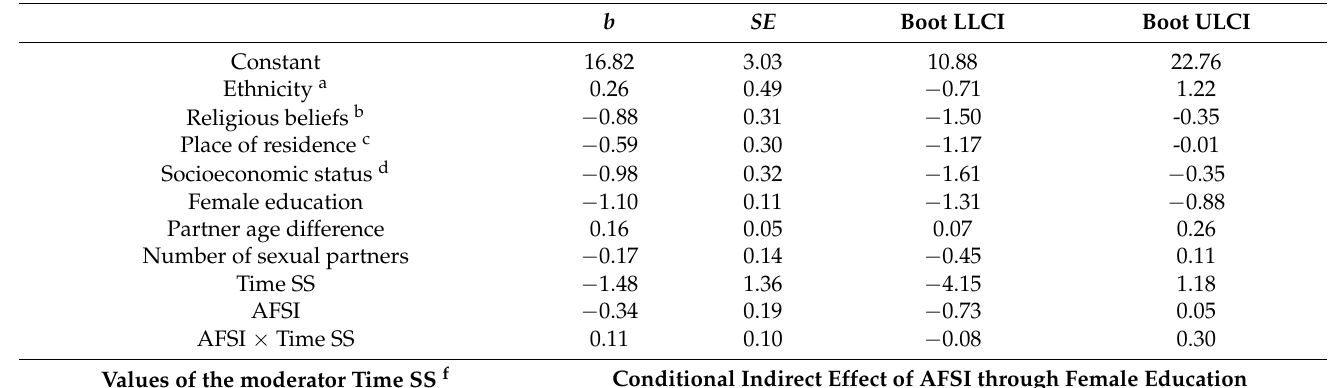
Table 3. Cont. Dependent Variable Model (Predicting Unintended Pregnancy e